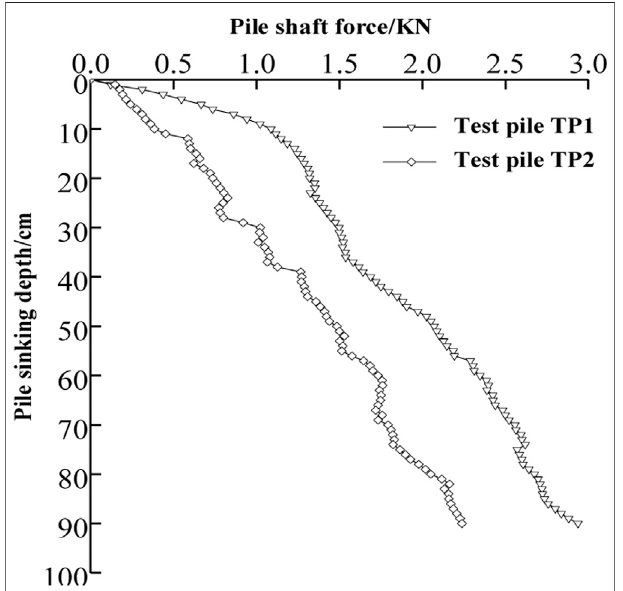
FIGURE 7 | Variation of pile force during pile jacking.